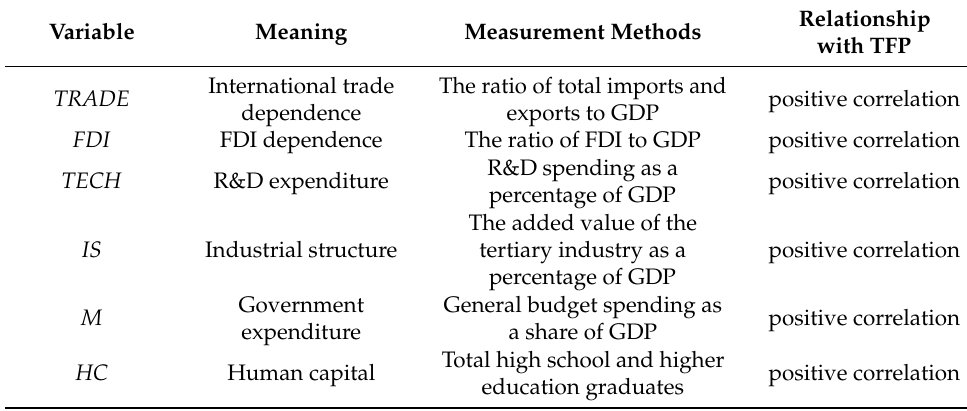
Table 1. Influencing factors of TFP selected and their relationship with